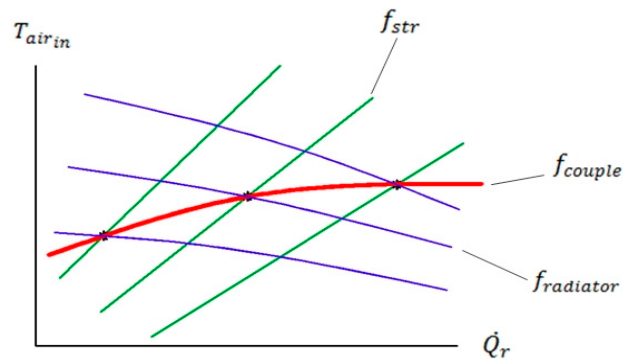
Figure 13. Coupling thermal transmission equation.